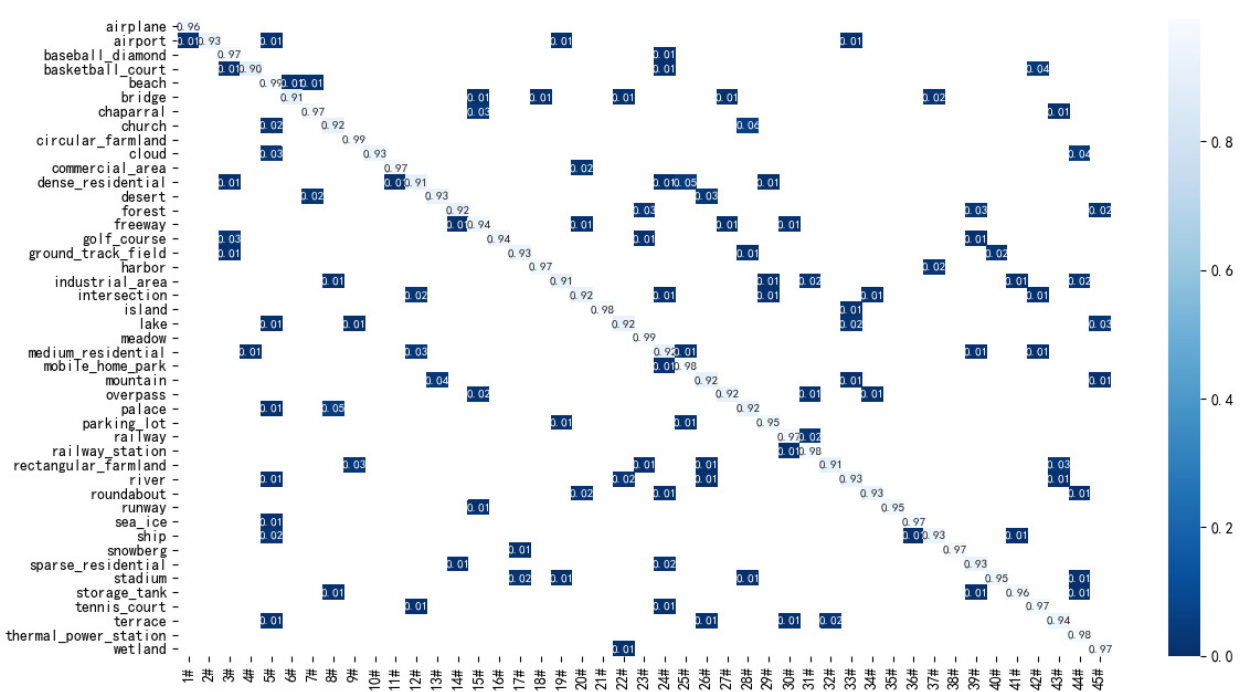
Figure 13. Confusion matrix of the proposed method on the NWPU dataset with 20% training ratio.